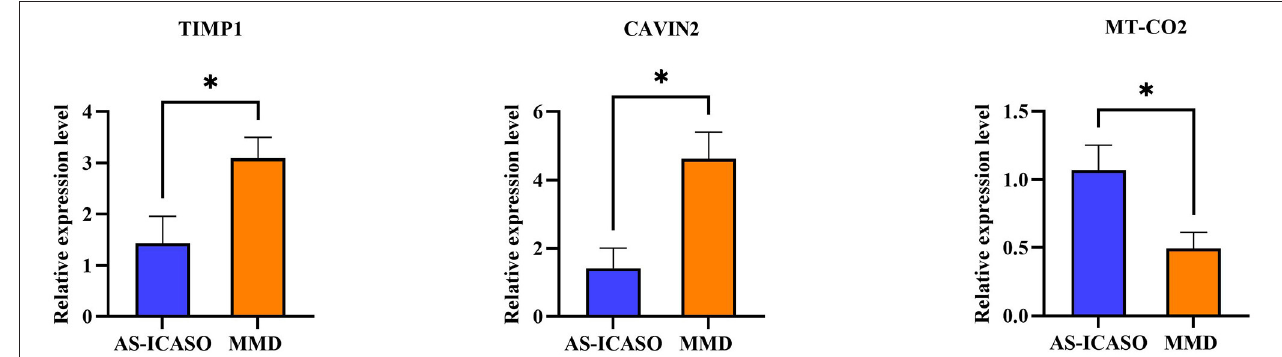
FIGURE 3 | Quantitative polymerase chain reaction (qPCR) validation of the selected genes. The validation of the RNA-sequencing (RNA-seq) results using qPCR in independent samples including nine patients with MMD and six AS-ICASO controls. The relative expression level of mRNA is shown. Expression values are first normalized to glyceraldehyde 3-phosphate dehydrogenase (GAPDH; internal control) and then plotted relative to corresponding controls that are set as one for each gene. Error bar represents mean ± standard error of the mean (SEM). Unpaired student’s t -test is used to calculate significant differences. * p <